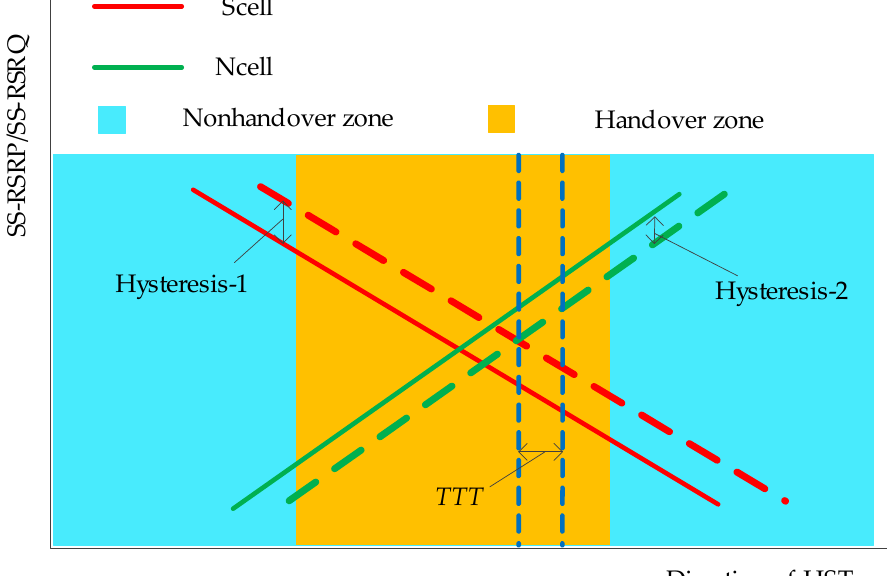
Figure 9. Trigger point of the